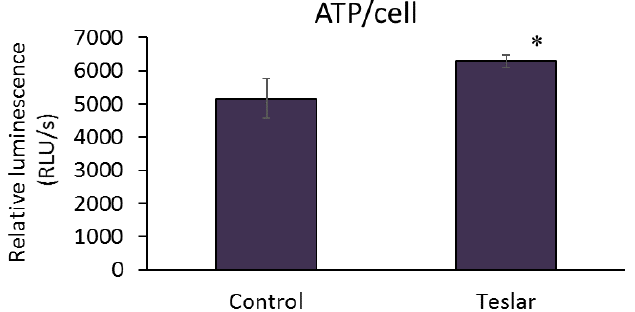
Figure 4. Teslar effect on cellular ATP levels in collagen gel-cultured human fibroblasts. The results are expressed as the mean ± standard deviation of three experiments. * p < 0.05 vs. Control.